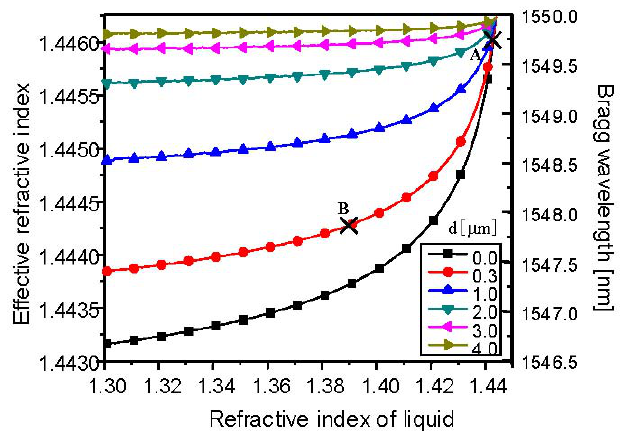
Figure 2. Effective refractive index and Bragg wavelength of cladding-etched single-mode FBG in relation to the refractive index of the external medium for various remaining-cladding